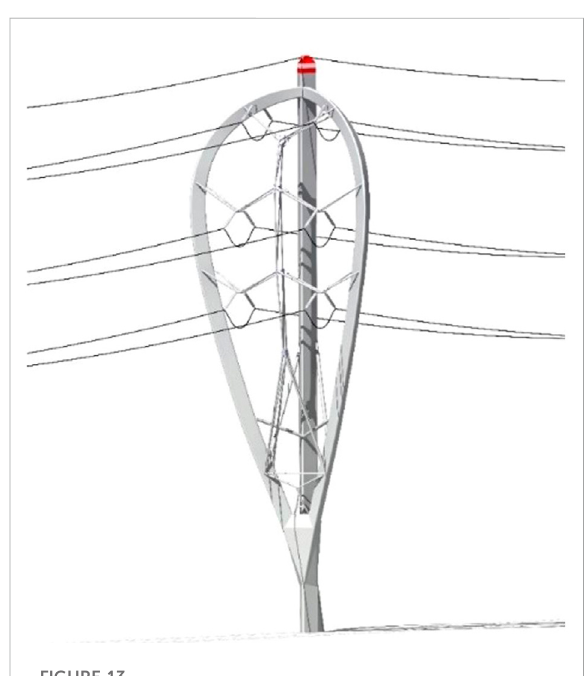
FIGURE 13 Render of the proposed